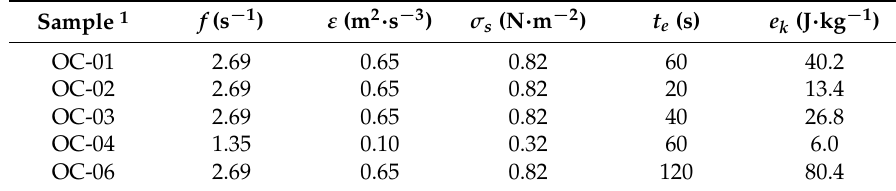
Table 2. Parameters and values for cycle B hydrodynamic shear stress